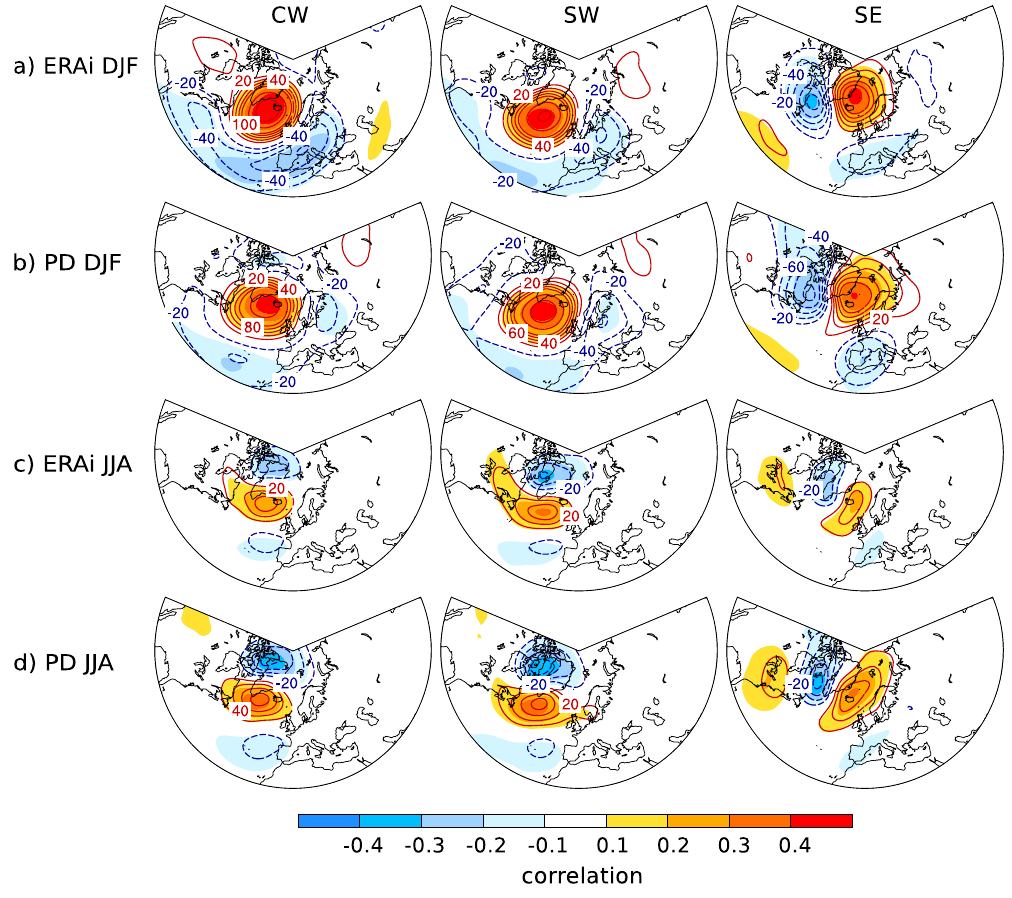
Fig. 10. z500 correlation and positive composite patterns associated with daily precipitation in CW, SW and SE for (a) ERAi winters (DJF), (b) PD winters, (c) ERAi summers (JJA) and (d) PD summers. The shading illustrates the correlation pattern for values ≥ 0.1 and ≤− 0.1 (significant at the 1% level due to the large sample size of ≥ 2700 days for each season). Contour lines illustrate the z500 positive composite (in geopotential height meters) expressed as anomaly from seasonal mean z500. The positive composite samples all days with ≥ 1 standard deviation in daily